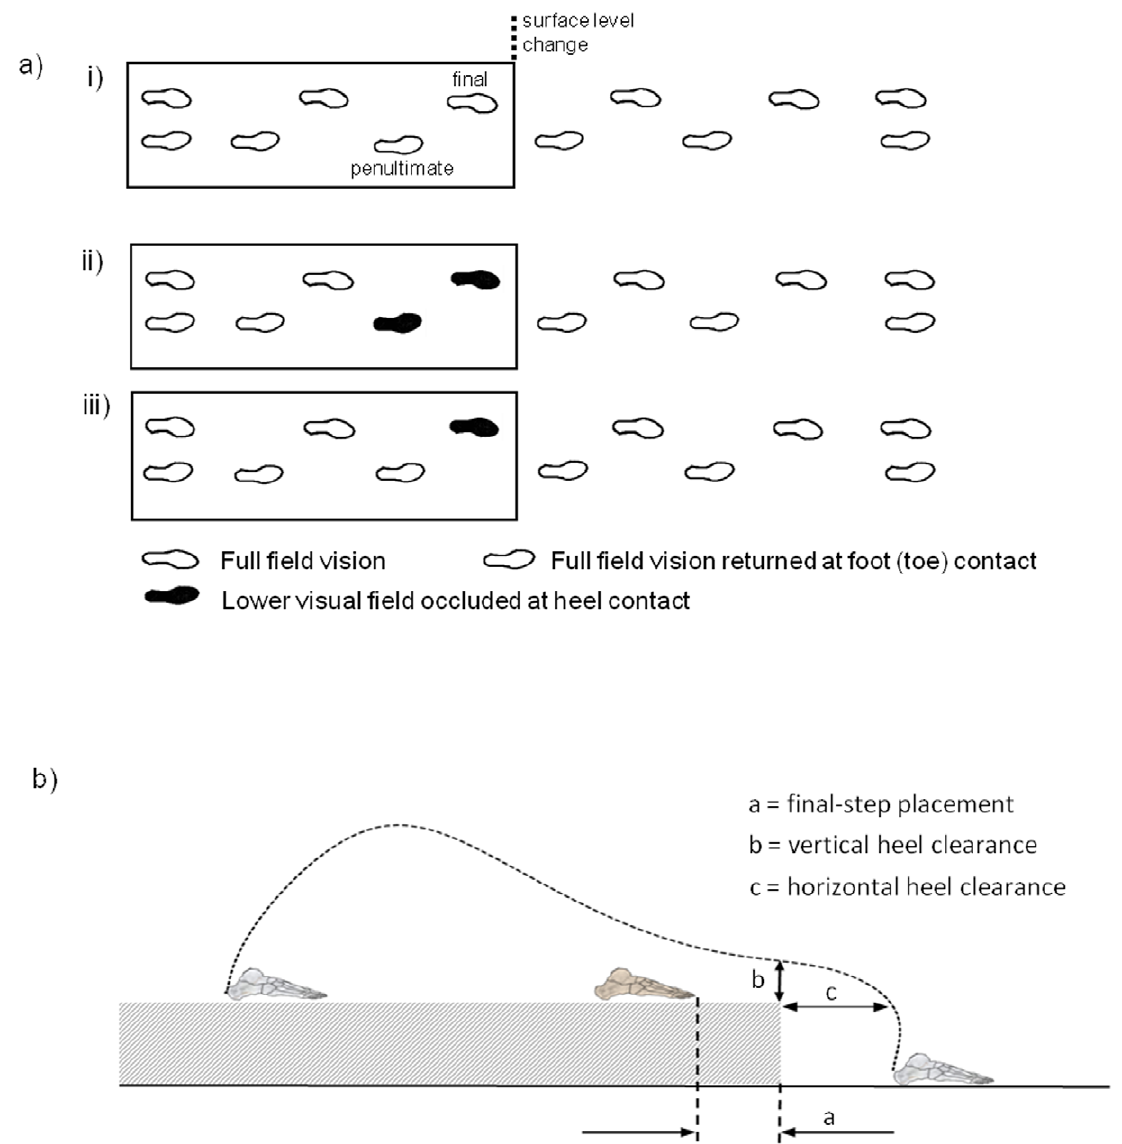
Figure 1. Schematic of the experimental set-up and how foot placement and heel clearance parameters were determined. a) The three visual conditions: i) no visual occlusion, ii) lower visual field occlusion from penultimate step heel contact iii) lower visual field occlusion from final step heel contact, and b) foot placement and heel clearance parameters.